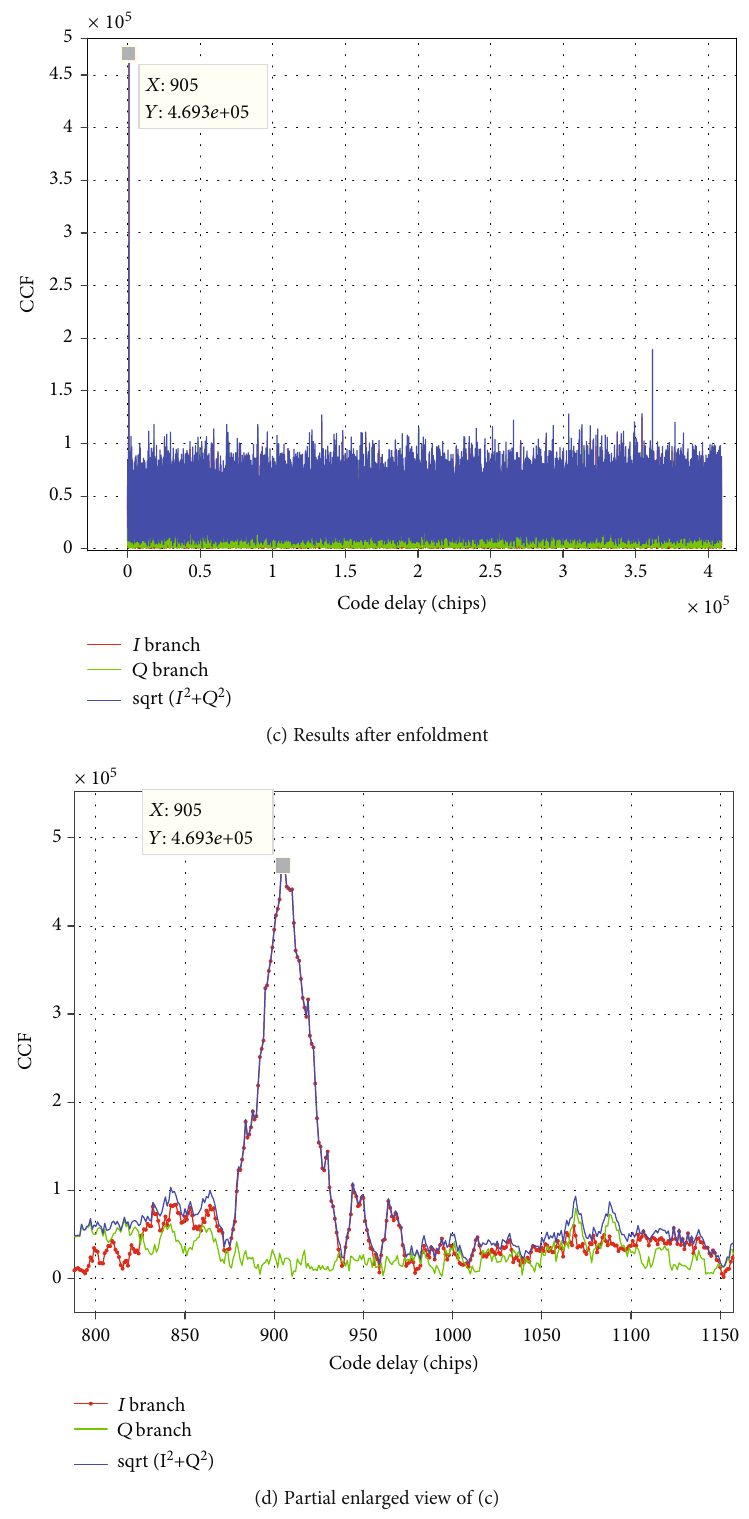
Figure 6: Correlation results of the adjacent Figure 10. It can be seen from the fi gure that the correlation peak corresponding to the correct frequency exceeds the left and right adjacent frequencies, which avoids false detection.